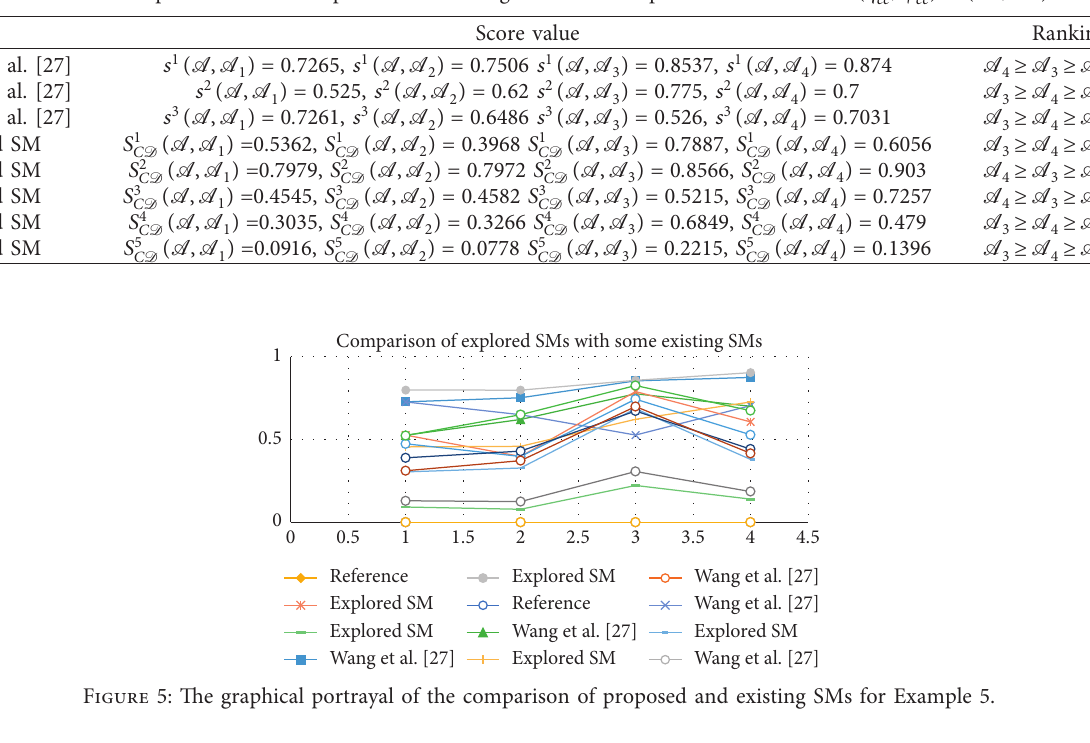
, ϕ ) � ( 0 . 5 , 0 . 5 ) . cc cc